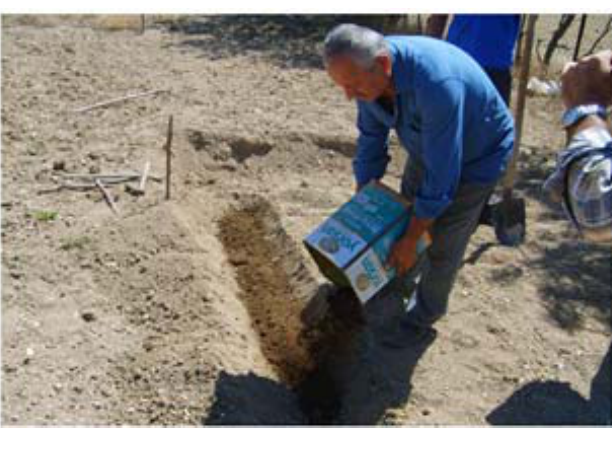
Figure 5. Saffron bulbs being covered with organic matter.